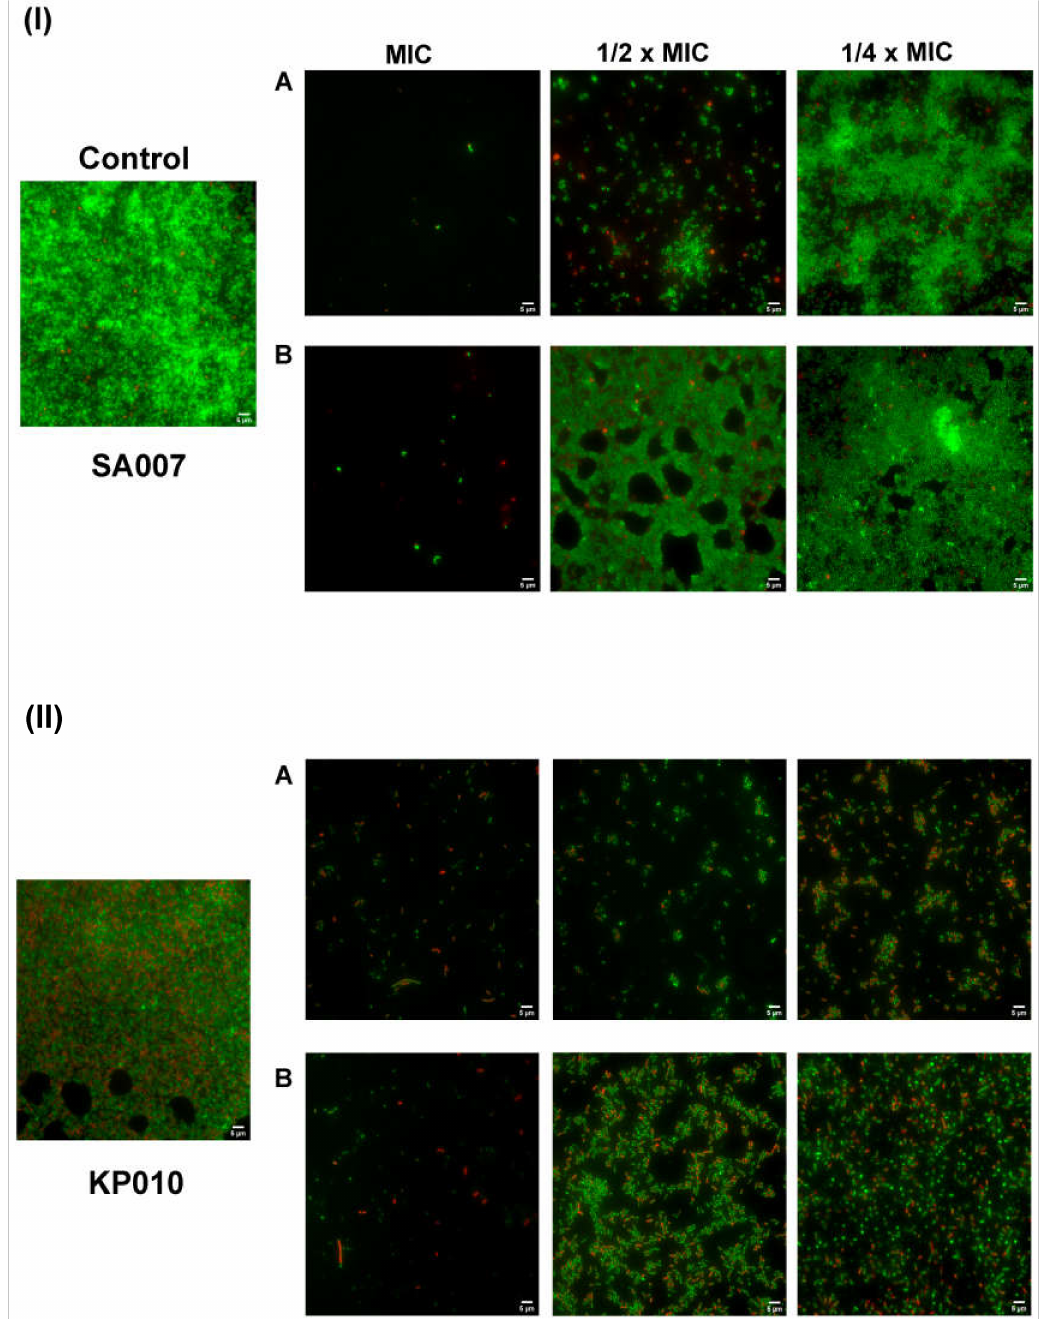
Figure 2. Fluorescence microscopy representative images of biofilms formed by MDR clinical isolates ( I ) S. aureus SA007, and ( II ) K. pneumoniae KP010, in the absence (control) or in presence of the test peptides ( A ) PP4-3.1 and ( B ) MeIm-PP4-3.1, at MIC, 1 / 2 × MIC and 1 / 4 × MIC. The Live/Dead™ BacLight™ Bacterial Viability staining kit was used, which stains in green (SYTO 9 fluorescence) live bacteria, and stains in red (propidium iodide) dead or dying bacteria (with a damaged membrane). Scale bar corresponds to 5 µ